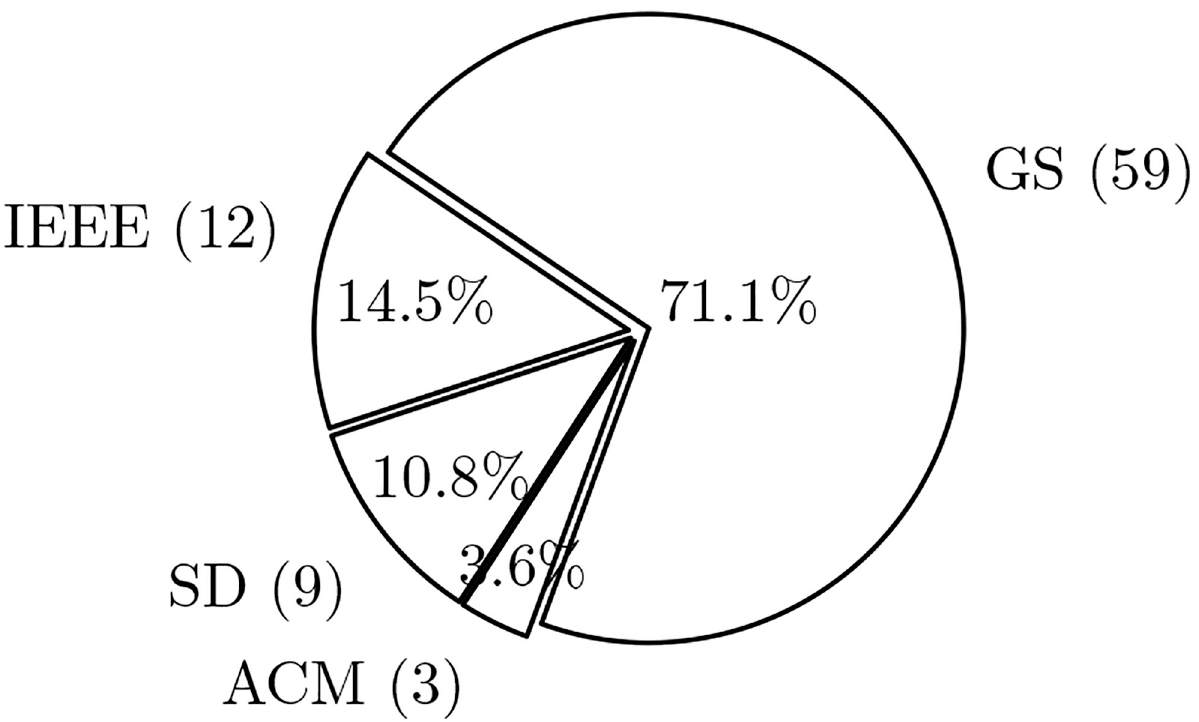
Fig 3. Papers distribution by databases. The pie chart shows the percentage of papers found in the databases we considered in this study. Acronyms used: GS—Google Scholar, IEEE—IEEE Xplore, SD—ScienceDirect. The number of papers is given in brackets.